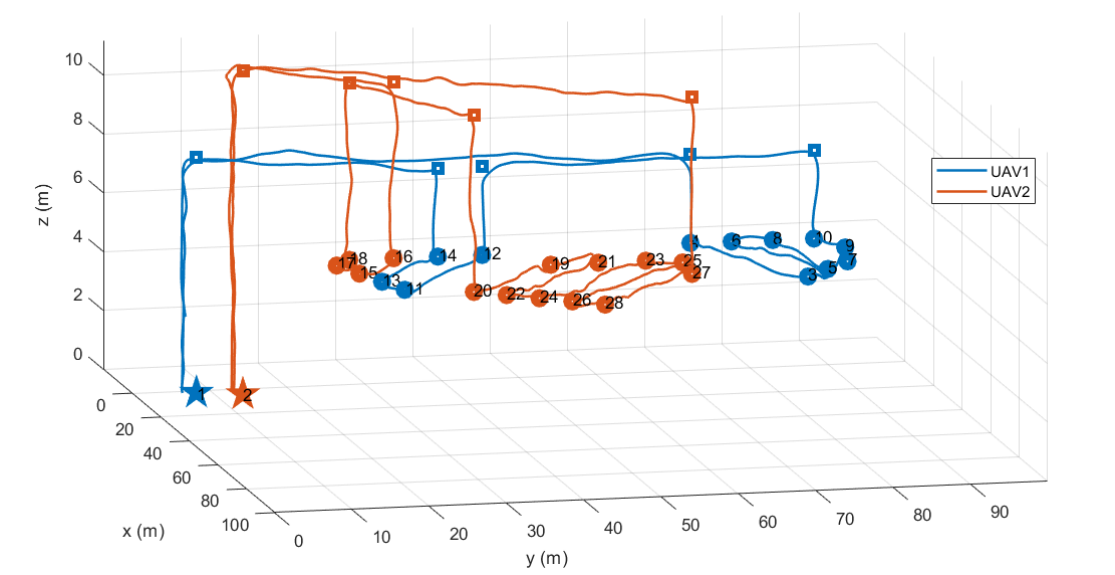
Figure 15. Flight